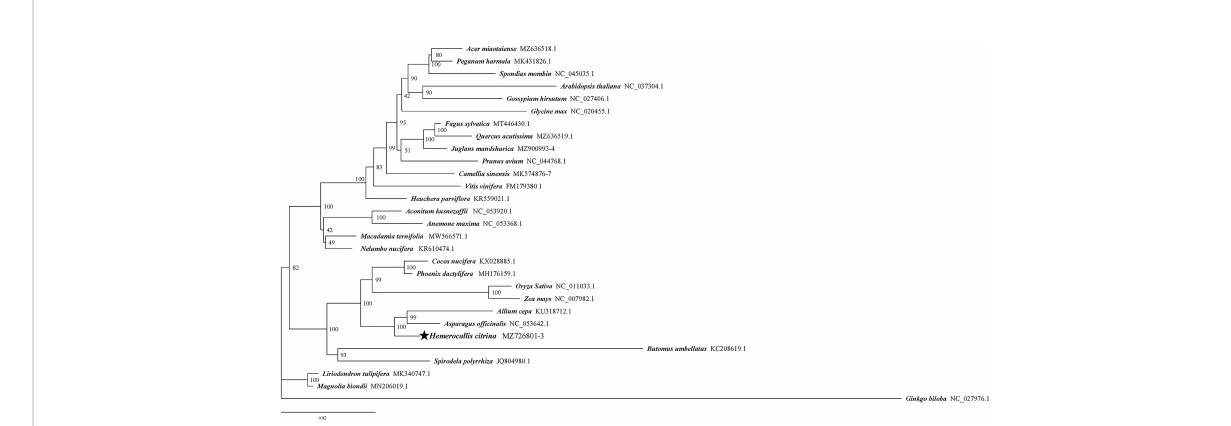
FIGURE 6 Maximum likelihood phylogenetic tree for H. citrina according to 29 complete mitogenomic sequences, with Ginkgo biloba as an outgroup. The bootstrap index value in which the associated taxa clustered together is indicated next to the branches, and the NCBI accession numbers are listed beside the abbreviations of the